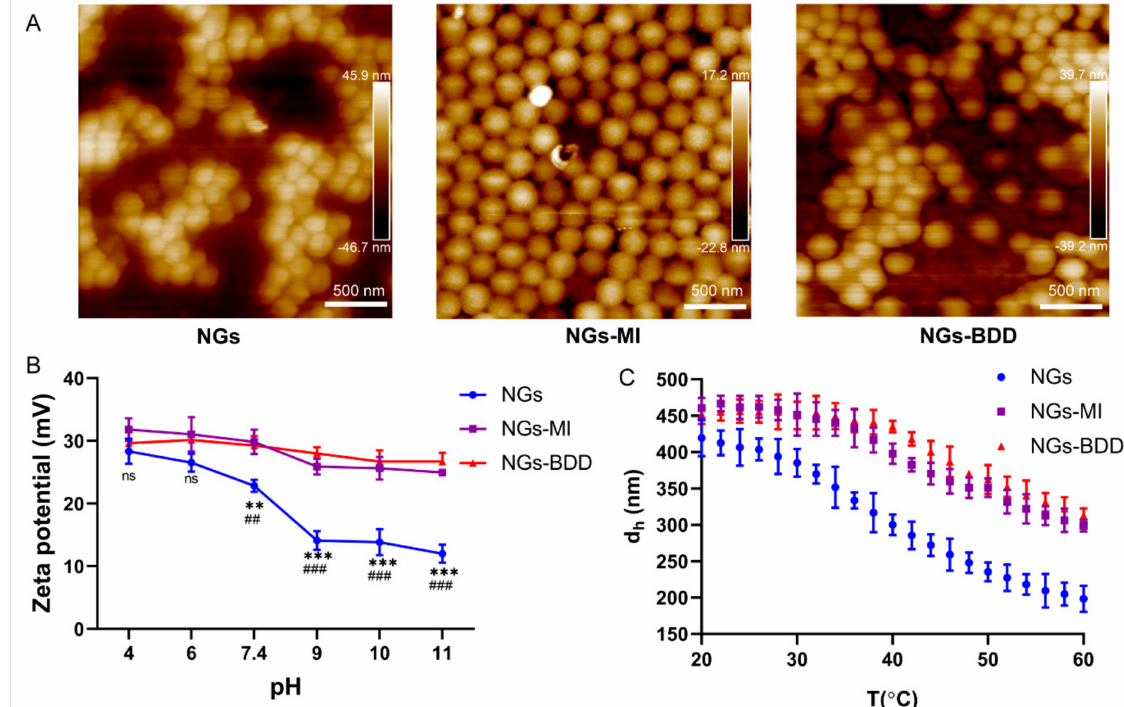
Figure 2. Characterization of NGs, NGs-MI, and NGs-BDD nanogels. ( A ) Atomic force microscopy (AFM) images of nanogels in the dry state at room temperature. ( B ) pH-dependent zeta potential of nanogels in 0.05 M NaCl at 25 ◦ C. ( n = 3; ** p and ## p < 0.005, *** p and ### p < 0.001 with * indicating comparison with NGs, # indicating comparison with NGs-MI). ( C ) Temperature-dependent hydrodynamic diameter of nanogels in